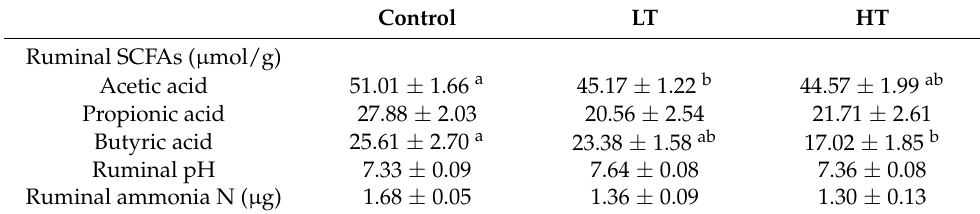
Table 4. Effect of TA on cecal fermentation of Brandt’s